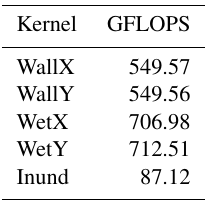
Table 2. Kernel performance for one GPU in